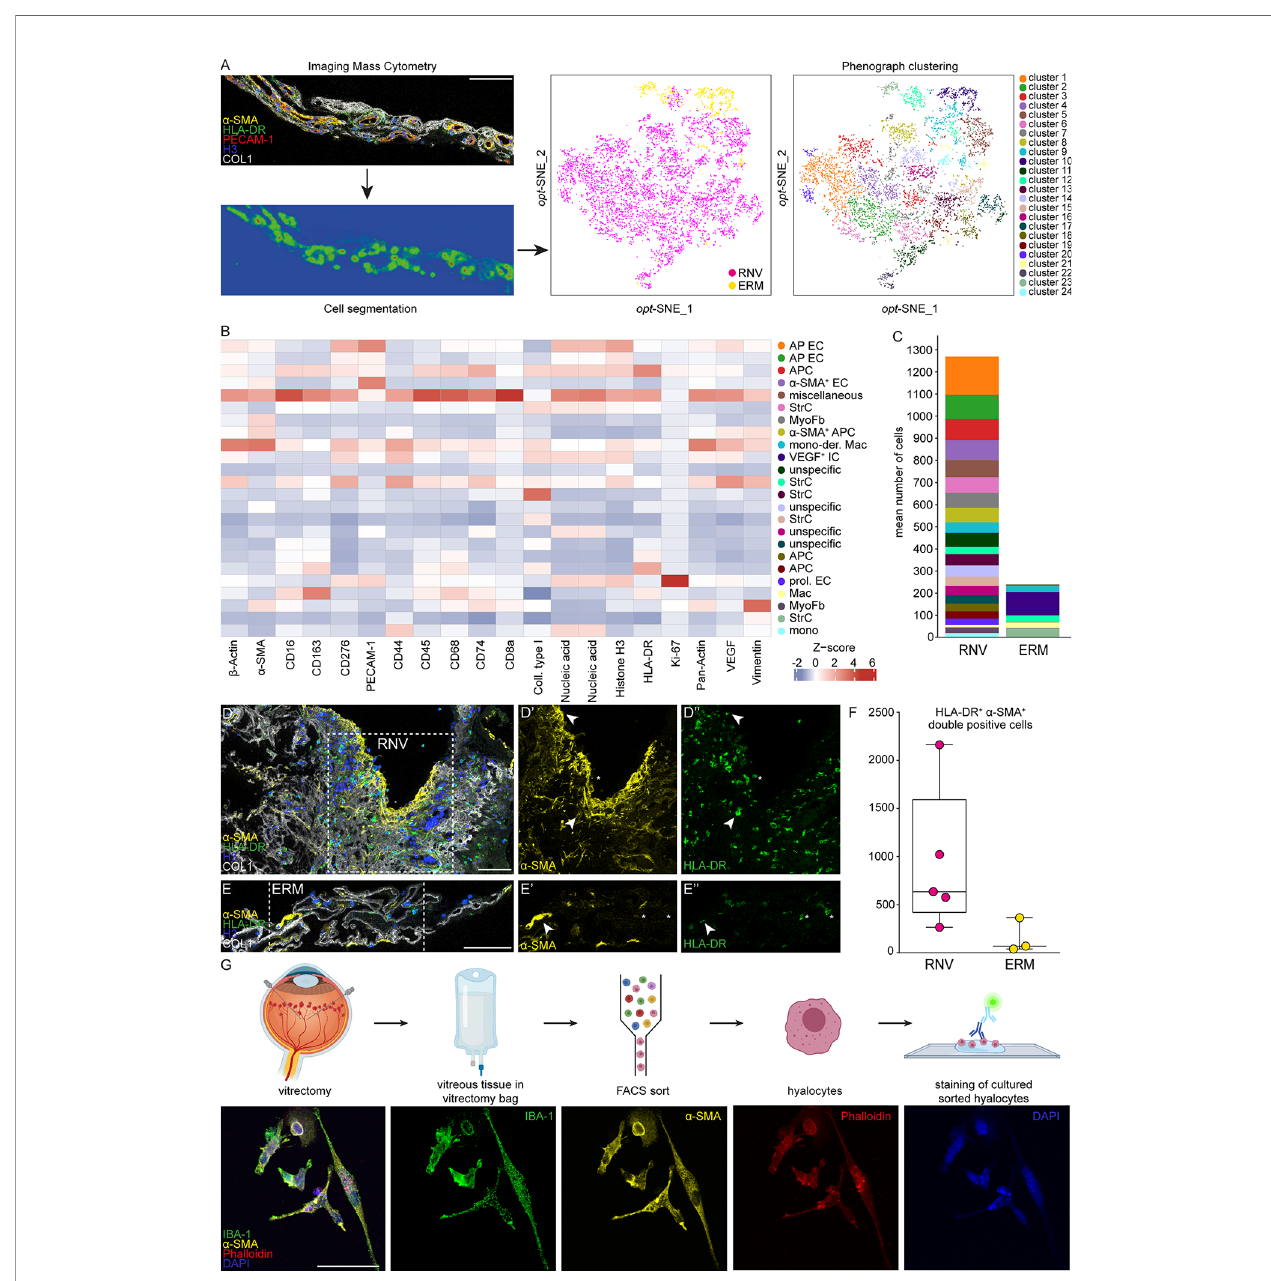
FIGURE 4 | Single-cell protein analysis of retinal neovascularization (RNV) reveals a pro- fi brotic in fl ammatory phenotype. (A) Highly multiplexed Imaging Mass Cytometry data was segmented into cellular masks via supervised machine learning. Finally, single-cell data was extracted and cells were attributed to 24 distinct clusters using Phenograph on an opt -SNE map. The data were further plotted to the cellular origin (RNV samples in magenta and epiretinal membrane (ERM) samples in yellow). (B) Heatmap of marker signal intensity in the Phenograph clusters depicted in A. Z-score: deviation from a marker ’ s mean expression in standard deviation units. Annotation of clusters was performed according to speci fi c marker expression. AP EC, antigen-presenting endothelial cells. APC, antigen-presenting cells. a -SMA + EC, a -smooth muscle actin positive endothelial cells. StrC, stroma cells. MyoFb, myo fi broblasts. mono-der. Mac, monocyte-derived macrophages. VEGF + IC, vascular endothelial growth factor positive immune cells. prol. EC, proliferating endothelial cells. (C) Cluster assembly was compared between RNV and ERM and visualized in stacked bar charts displaying mean counts per group. Multiplexed staining for HLA-DR (human leukocyte antigen – DR isotype, green), a - SMA ( a -smooth muscle actin, yellow), Histone H3 (blue) and COL1 (collagen type I, white) was performed on RNV (D) and ERM (E) samples. The single stainings ( a - SMA and HLA-DR) for the section within the dashed white square are shown in the panels to the right. Arrowheads point to double-positive HLA-DR + a -SMA + cells. Asterisks indicate a -SMA - HLA-DR + cells. Scale bars correspond to 100 m m. (F) Absolute cell counts of double-positive HLA-DR + a -SMA + cells were compared between RNV (magenta) and ERM (yellow) tissue samples. Data are presented as box-and-whiskers plots. Each dot represents one sample. (G) Upper panel: schematic illustrating the work fl ow for cultivation and staining of human hyalocytes. Lower panel: immunohistochemical staining of hyalocytes from a PDR patient for IBA-1 (green), a -SMA (yellow) and Phalloidin (red). Nuclei are counterstained with DAPI (4 ′ ,6-Diamidin-2-phenylindol). Scale bars correspond to 50 m